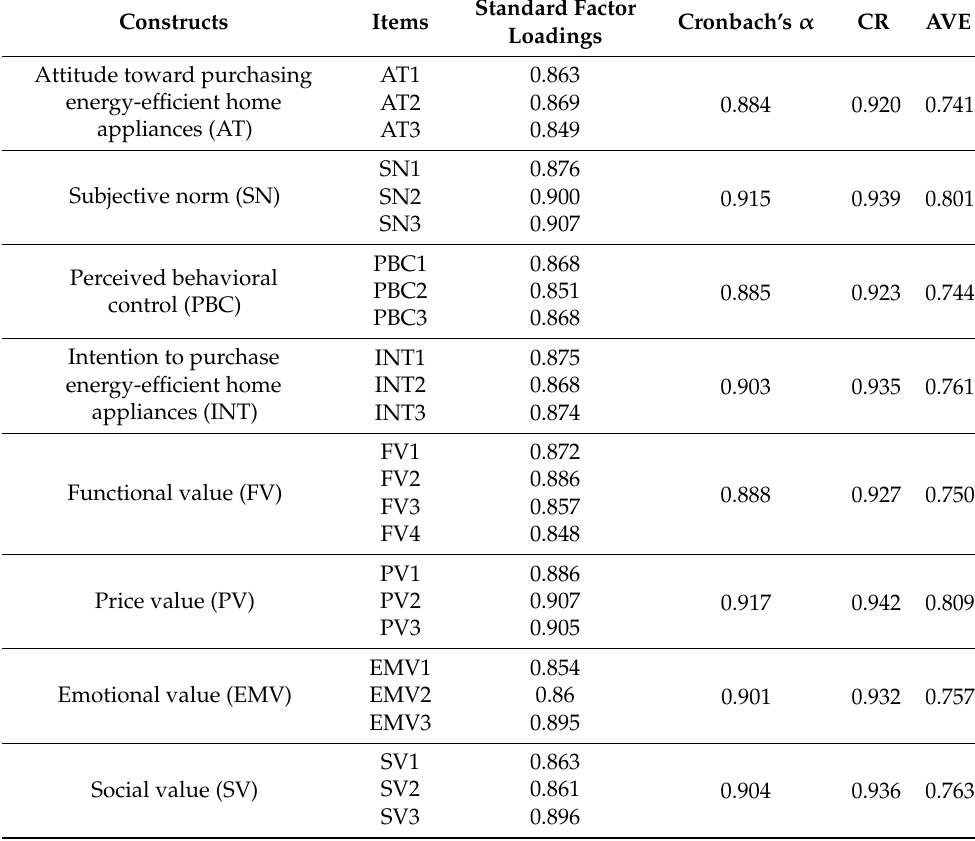
Table 3. Evaluation of validity and reliability of the measurement